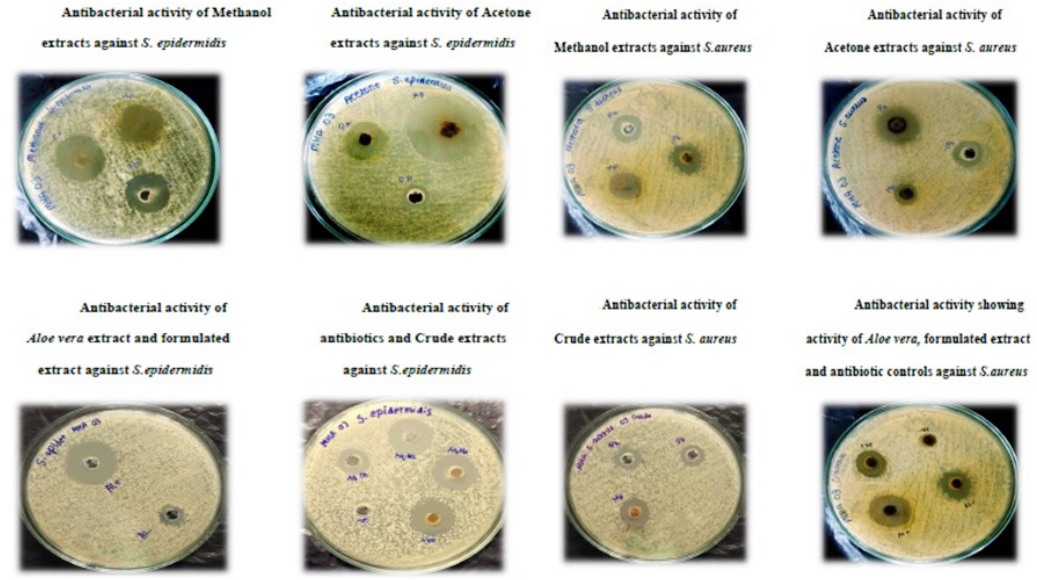
Fig. 1. Antibacterial activity of different extracts against the pathogens isolated